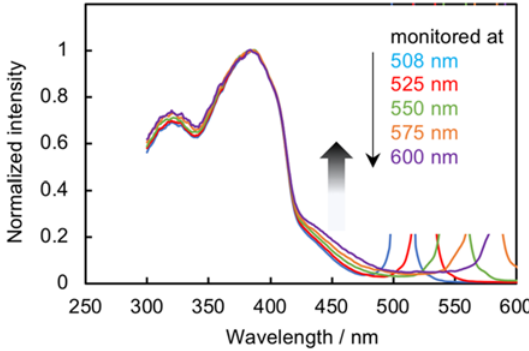
Figure 5. Excitation spectra of the soluble part of m - P1 in CHCl 3 (0.84 × 10 –5 M) at room temperature, monitored at 508, 525, 550, 575, and 600 nm. Intensities were normalized at peak tops around 380 nm.